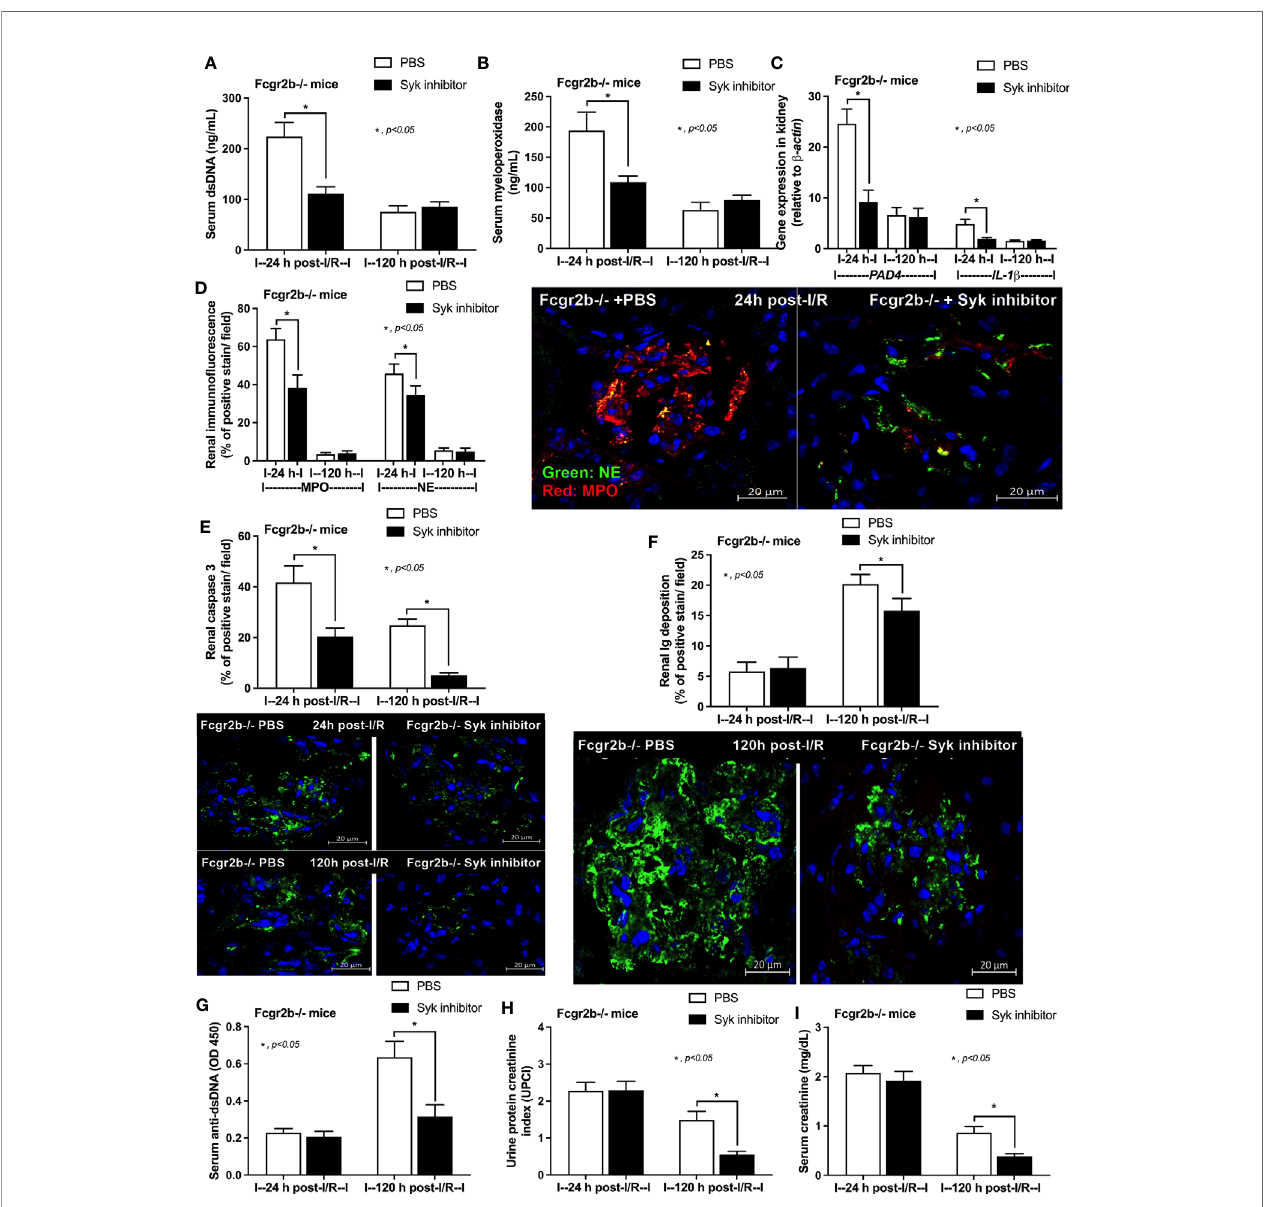
FIGURE 10 | Spleen tyrosine kinase (Syk) inhibitor decreased neutrophil extracellular traps (NETs) at 24 h after renal ischemia reperfusion injury (I/R) and attenuated lupus characteristics (anti-dsDNA, glomerular immunoglobulin deposition and lupus nephritis) at 120 h post-I/R in lupus prone mice. Characteristics of Fcgr2b-/- mice after renal I/R with Syk inhibitor or phosphate buffer solution (PBS) as determined by i) indicators of NETs in serum; serum dsDNA and serum myeloperoxidase (MPO) (A, B) , ii) NETs in kidneys; expression of PAD4 and IL-1 b (C) and co-staining of MPO and neutrophil elastase (NE) with the representative pictures (D) , iii) glomerular apoptosis (active caspase 3 staining) and immunoglobulin deposition with the representative pictures (E, F) , and iv) lupus nephritis characteristics; serum dsDNA, proteinuria (urine protein creatinine index; UPCI), and serum creatinine (G – I) are demonstrated (n = 5 –